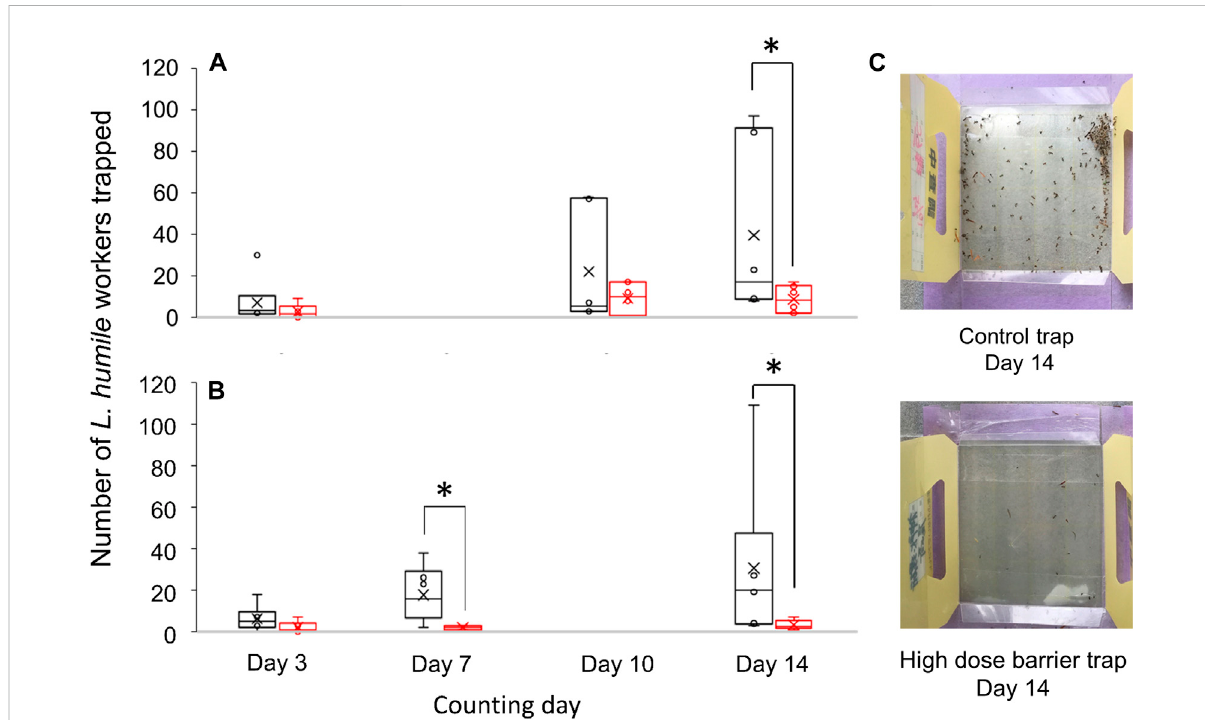
Comparison in the number of L. humile workers captured between the traps with or without barrier of ( Z )-9-tricosene. Field observation was donefor14days. (A) Numberofantscapturedbythelowdosebarrierof( Z )-9-tricosenetrapcomparedwiththatbythe( Z )-9-tricosene-freetrap. (B) Number of ants captured by the high dose barrier of ( Z )-9-tricosene trap compared with that by the ( Z )-9-tricosene-free trap. Asterisks indicate signi fi cantdifference( n =6, p < 0.05,Mann-Whitney ’ sUtest). (C) (Top,Bottom)Picturesofthecontroltrapandhighdosebarriertraponday14,